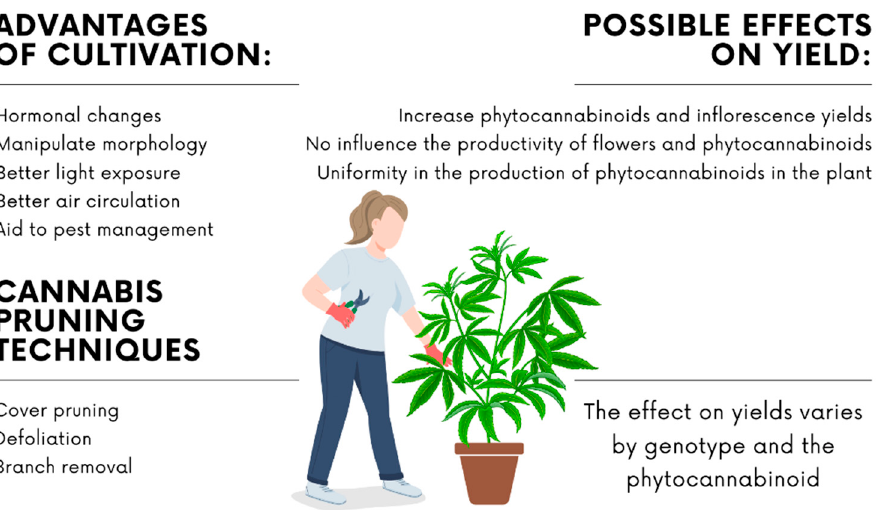
Figure 3. Main pruning techniques applied in cannabis cultivation (cover pruning, defoliation and branch removal) with an approach to the benefits and possible effects on productivity.